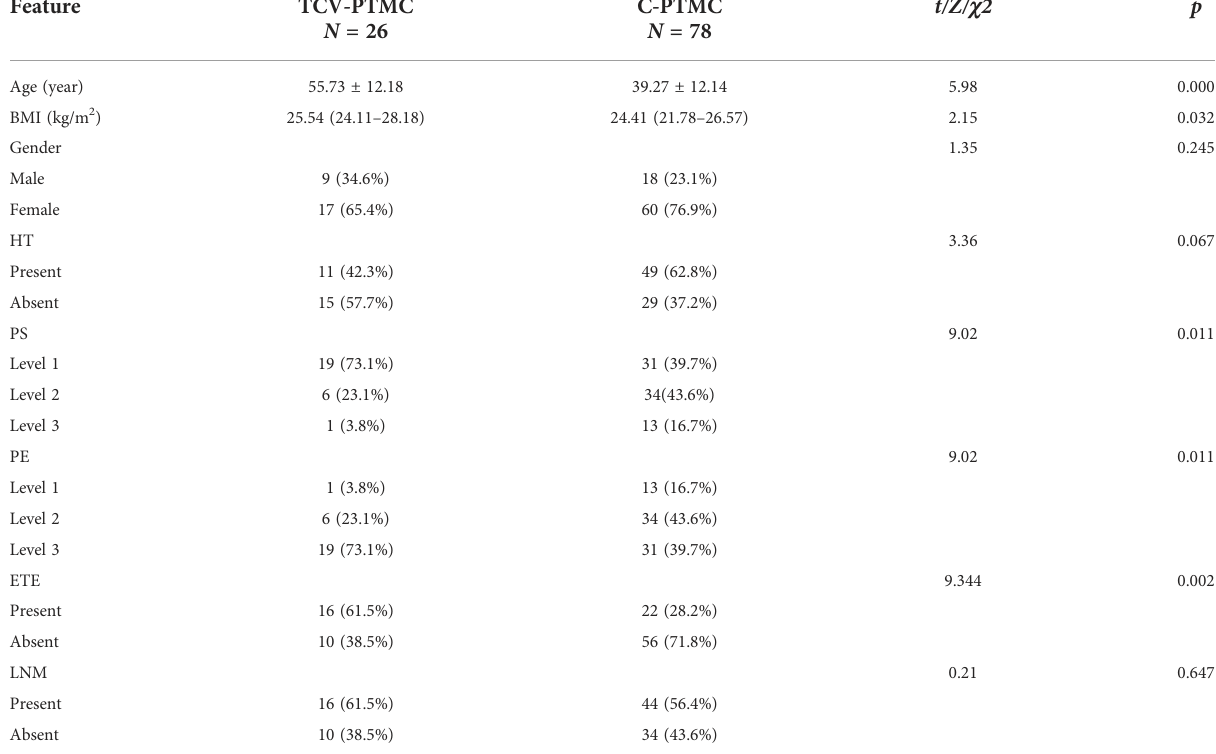
TABLE 1 Clinicopathological characteristics of TCV-PTMC and C-PTMC